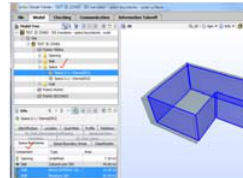
Fig. 2. Space Boundaries definition and aggregation of the single components (wall and slabs) of each room within the building. IFC format is exported to allow interoperability with others tools. Here VE tool for building’s thermal evaluation.